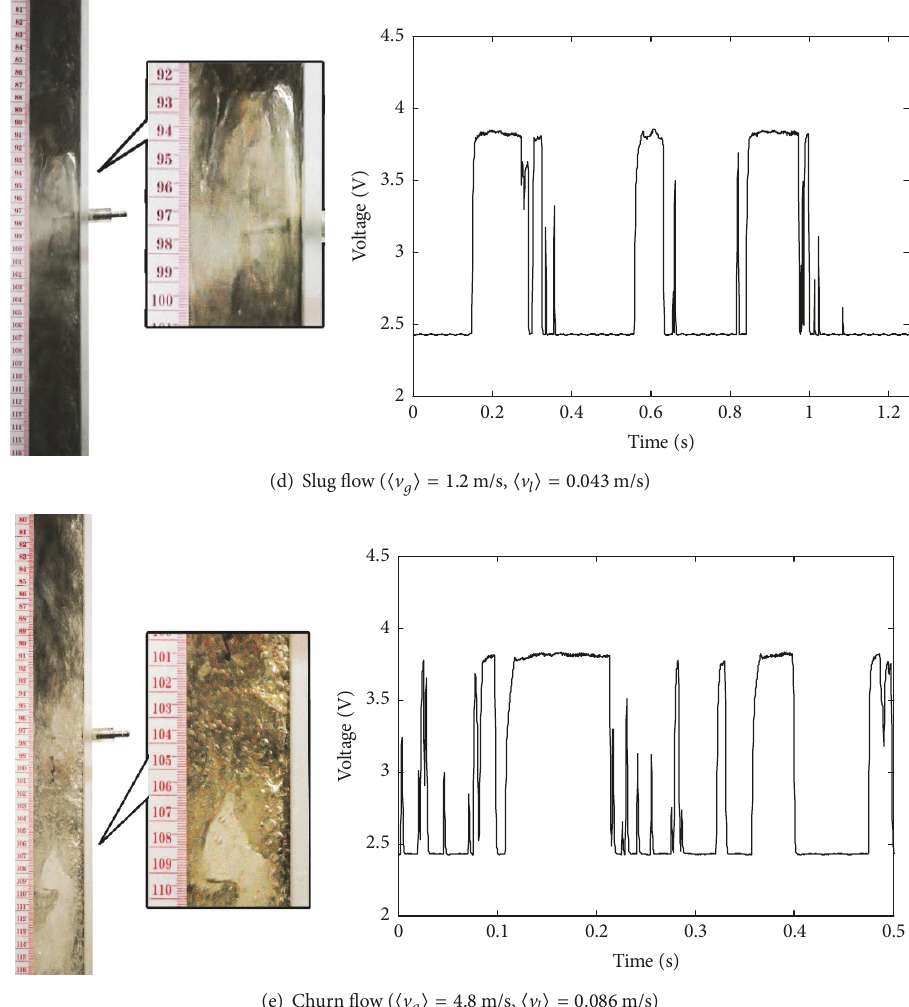
Figure 15: Flow structures and output signals for different flow